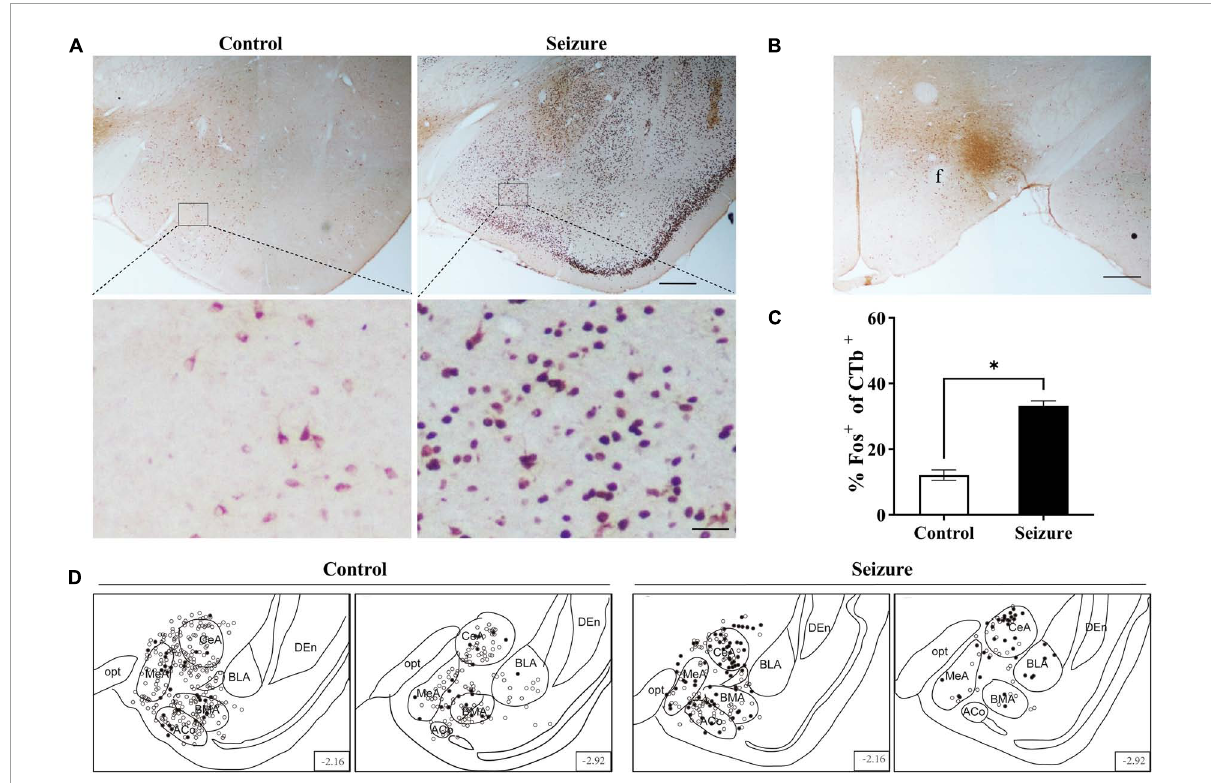
FIGURE6 Pilocarpine-induced statis epilepticus (SE) caused significant activation of amygdaloid neurons projecting to the lateral hypothalamus (LH). (A) Representative images of Fos (dark purple to black) and CTb (brown) immunostaining in the amygdala in a control and a pilocarpine-treated (seizure) rat pre-injected with CTb in LH as shown in (B) . Bar: 500 µ m in upper panels of (A) and in (B) , and 60 µ m in lower panels of (A) . (C) Bar graph showing the proportions of CTb-labeled amygdala neurons that were activated (Fos + ) in control and seizure rats. ∗ P < 0.05, n = 2 rats for each group, Student’s t -test. (D) The distribution of Fos + or Fos − CTb-labeled neurons in 4 rostral-caudal sections of the amygdala in control and seizure rats, with each clear circle representing 1 Fos − CTb-labeled neuron and each filled circle representing 1 Fos + CTb-labeled neuron. The numbers on the right lower corner of each section indicate the distance from the bregma. ACo, anterior cortical amygdaloid nucleus; BLA, basolateral amygdaloid nucleus; BMA, basomedial amygdaloid nucleus, anterior part; CeA, central amygdaloid nucleus; DEn, dorsal endopiriform nucleus; f, fornix; MeA, medial amygdaloid nucleus, anterior part; opt, optic